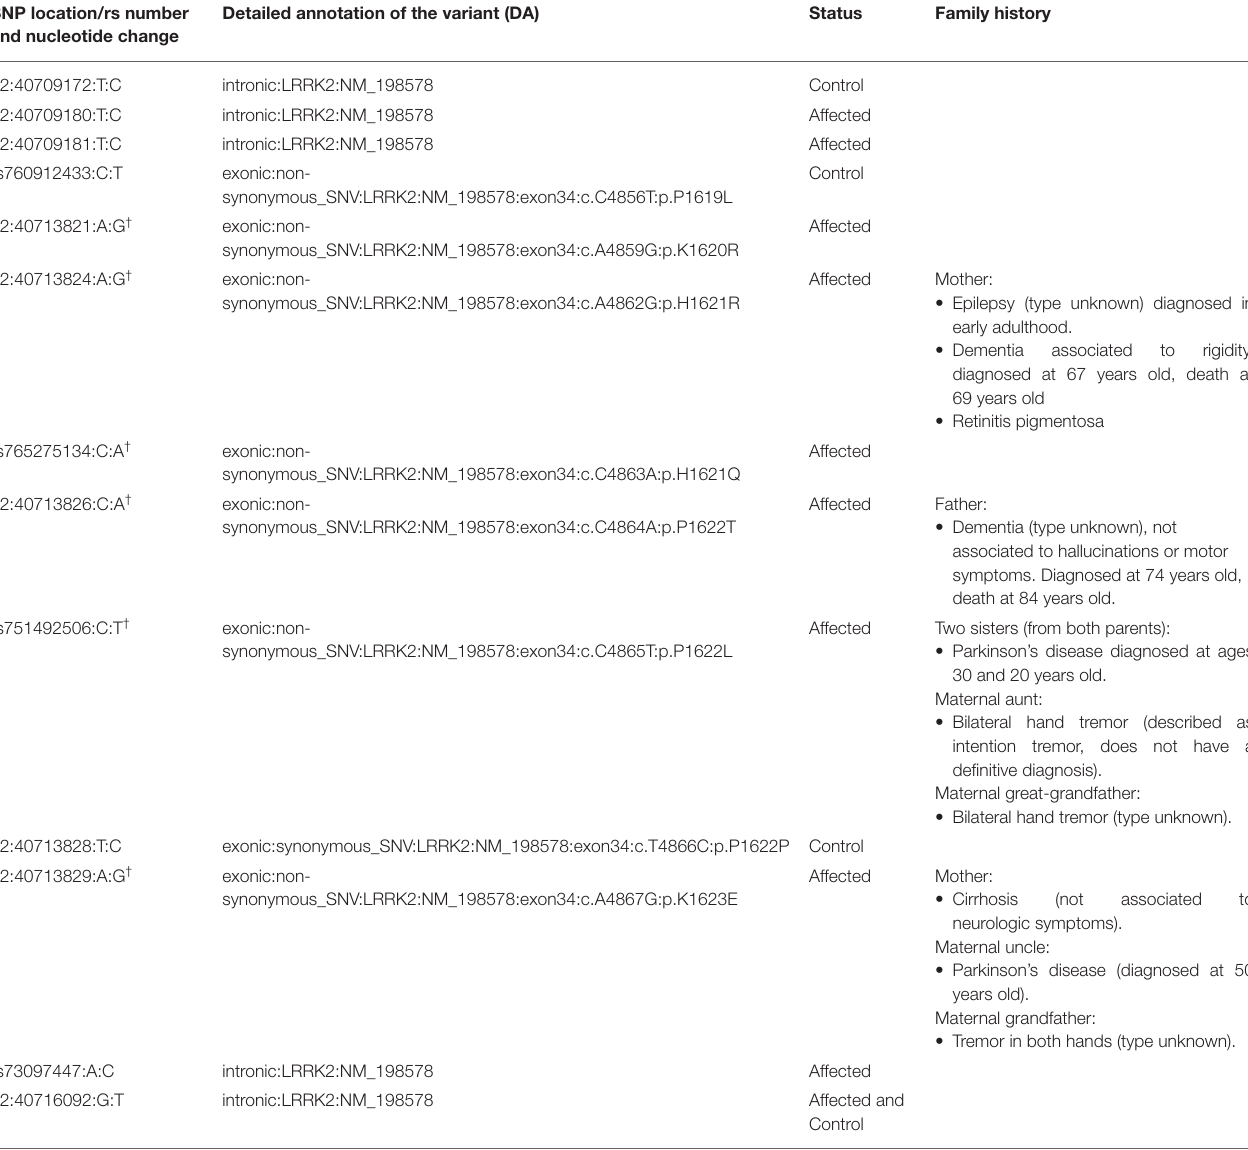
TABLE 4 | Rare variants in LRRK2 present in patients and controls. SNP location/rs number Detailed annotation of the variant and nucleotide change